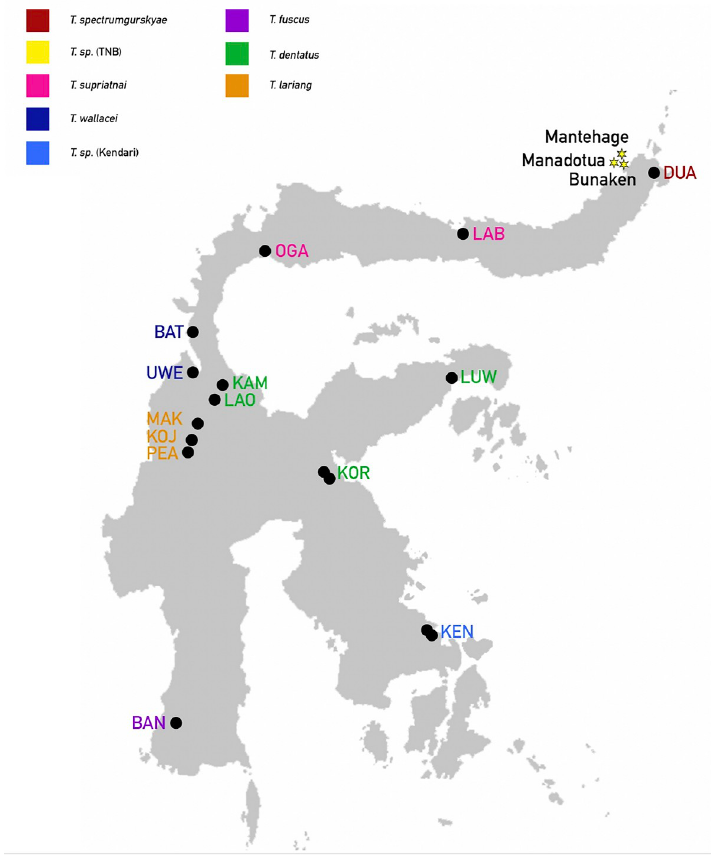
Fig 4. Origins of DNA sample from 17 populations of eastern tarsier. Stars: this study (red: Bunaken; orange: Manadotua; yellow: Mantehage; see Fig 1). Black dots: Driller et al. (2015).